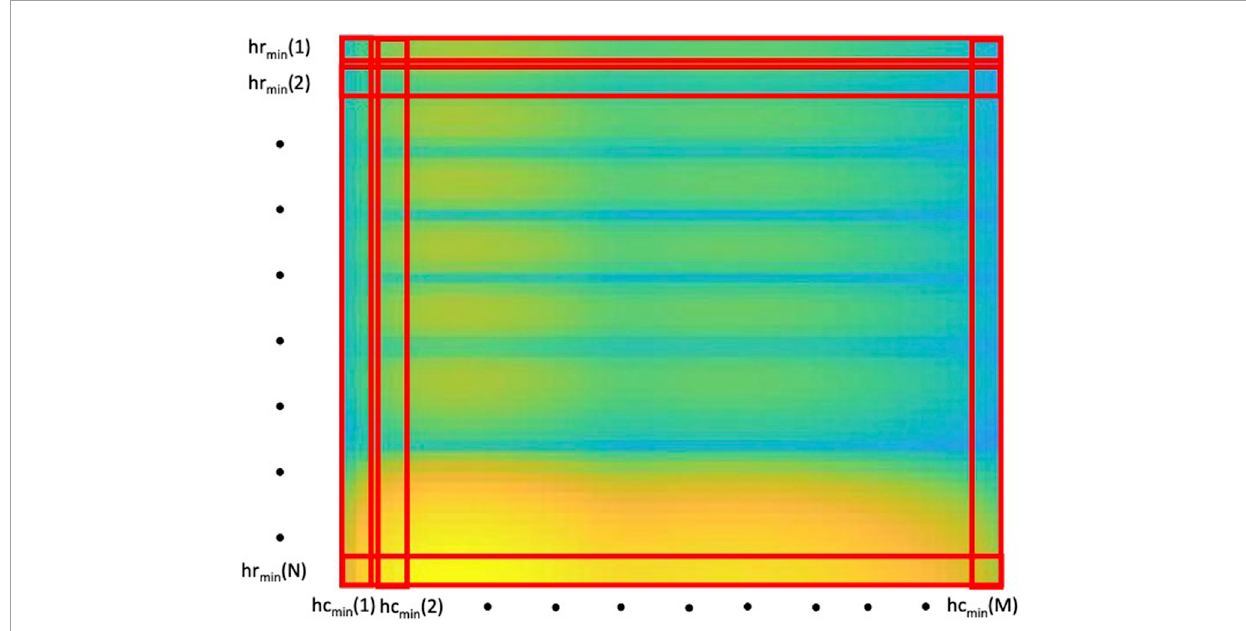
FIGURE 2 Computation of the 2D-SCSA’s design parameters h . hr min and hc min represent the h min values extracted from every row and every column of the spectrogram